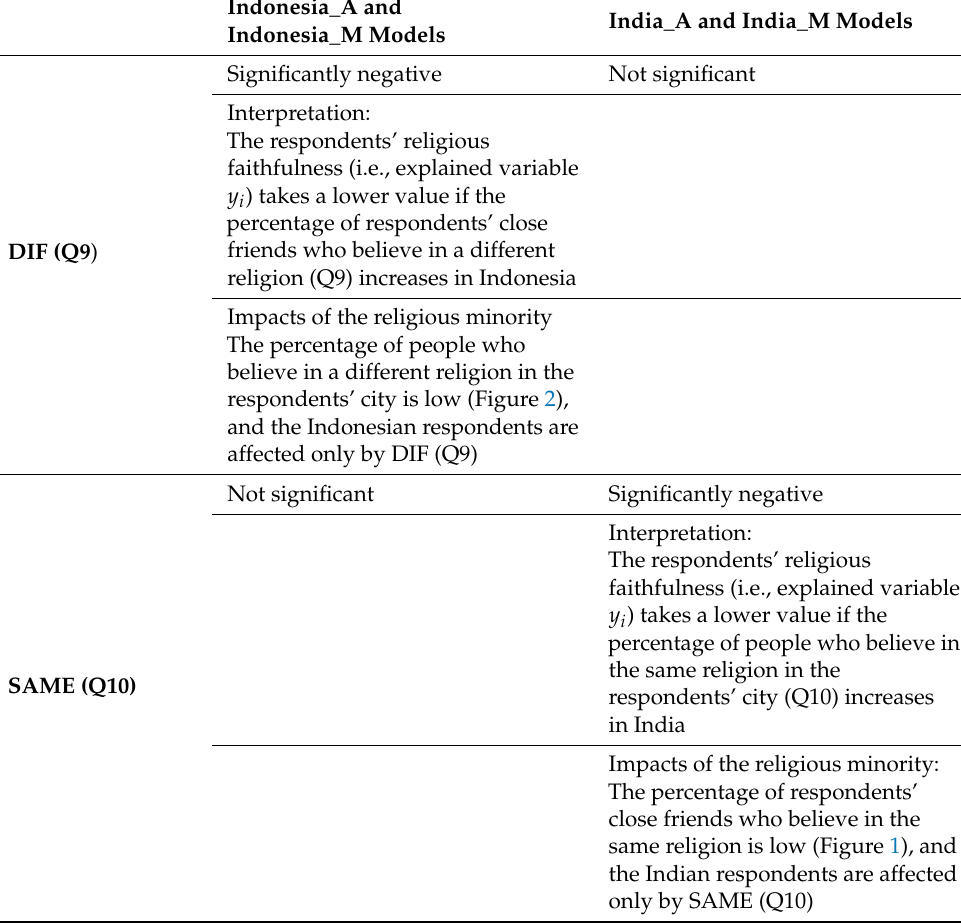
Table 8. Summary of the main